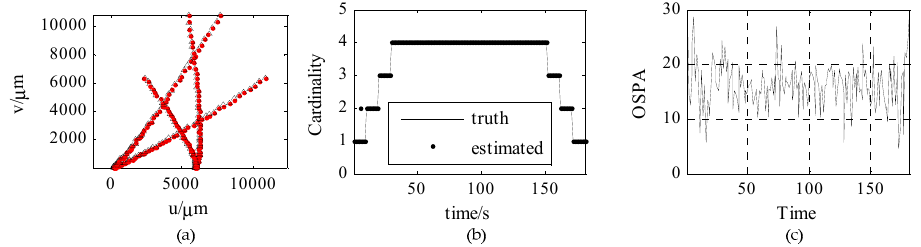
Figure 12. Trajectory tracking, cardinality estimated, and OSPA based on traditional measurement. ( a ) is trajectory tracking, ( b ) is cardinality estimated, ( c ) is OSPA.